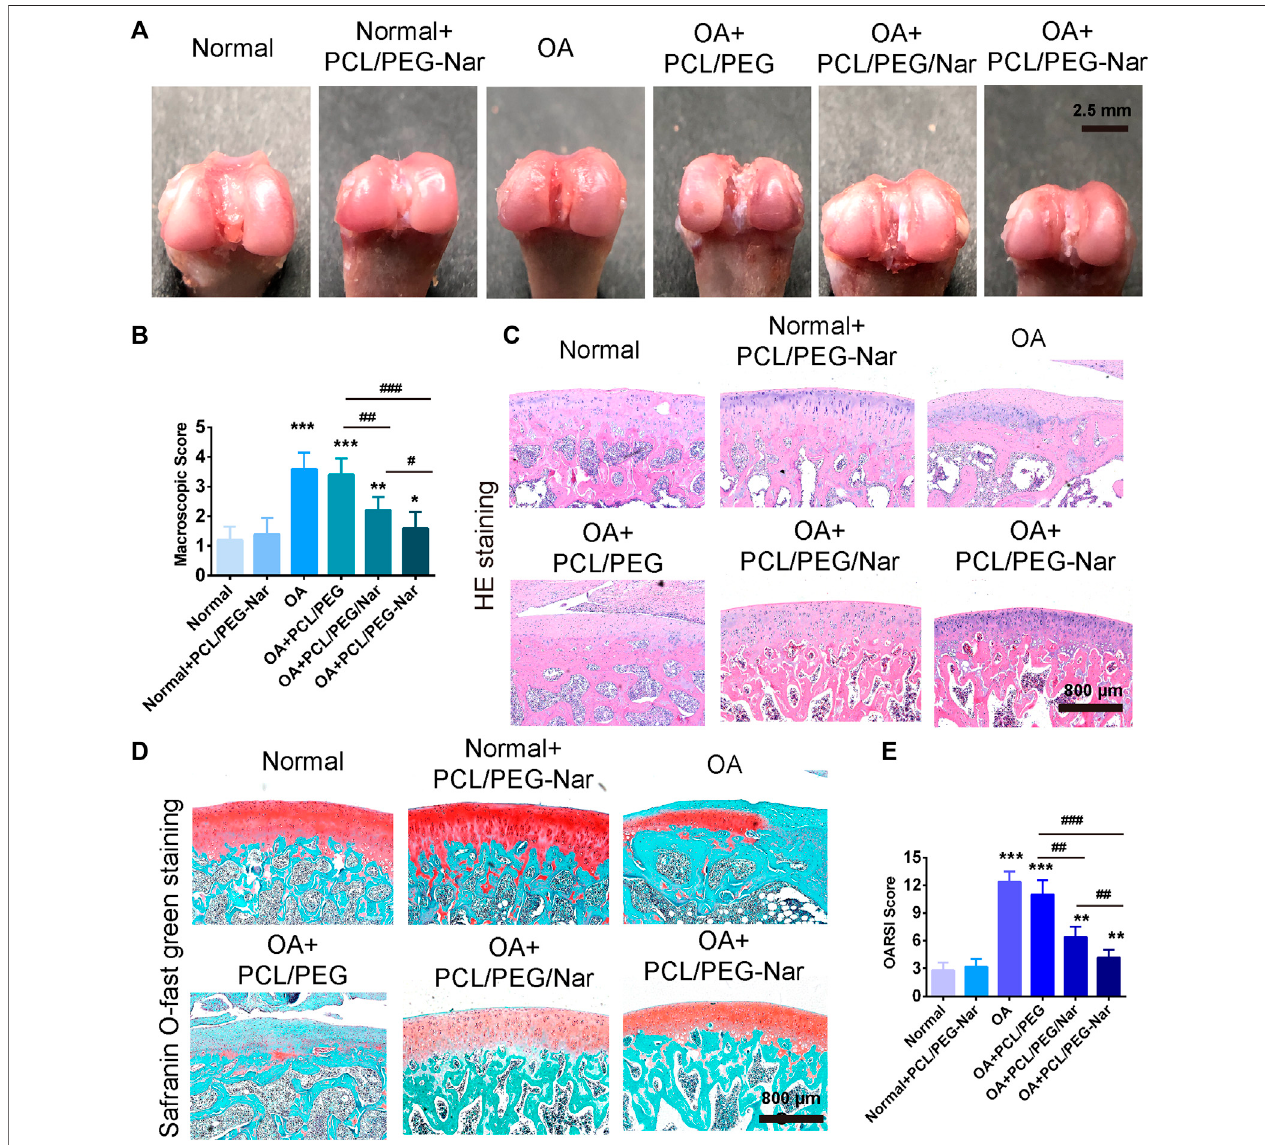
FIGURE6| EffectofPCL/PEG-NaronattenuatingOAprogression invivo .Themacroscopicobservation (A) andmacroscopicscore (B) ofcartilageaftertreatment with the PCL/PEG-Nar nano fi brousmembrane for 4 weeks. (C,D) H&E staining and safranin O/fast green staining. Scale bar: 800 μ m. (E) OARSI score to evaluate cartilagedegenerationanddamageafterPCL/PEG-Narnano fi brousmembranetherapyfor4weeks.Mean±SD;n=3;*indicates p < 0.05,**indicates p < 0.01,and*** indicates p < 0.001 compared with the normal group; # indicates p < 0.05, ## indicates p < 0.01, and ### indicates p < 0.001 with comparison between groups.